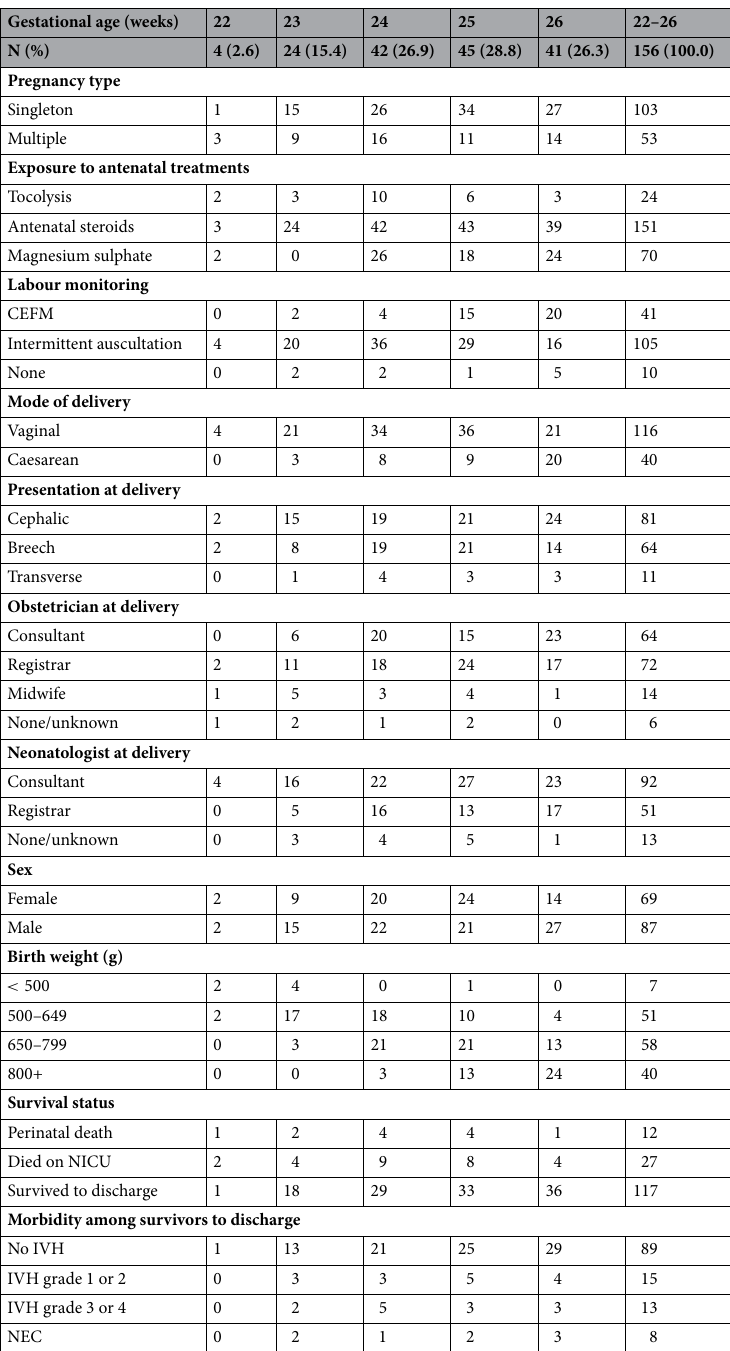
Table 1. Information for fetuses (or babies) born between 22 + 0 and 26 + 6 completed weeks of gestation between 1st January 2011 and 31st December 2013 at University College London Hospital NHS Foundation Trust who were alive at the onset of labour or when a decision was made to perform Caesarean section. CEFM continuous external fetal monitoring, NICU neonatal intensive care unit, IVH intraventricular haemorrhage, graded according to Papille’s classification, NEC necrotising enterocolitis, Bell’s classification stage 2 or